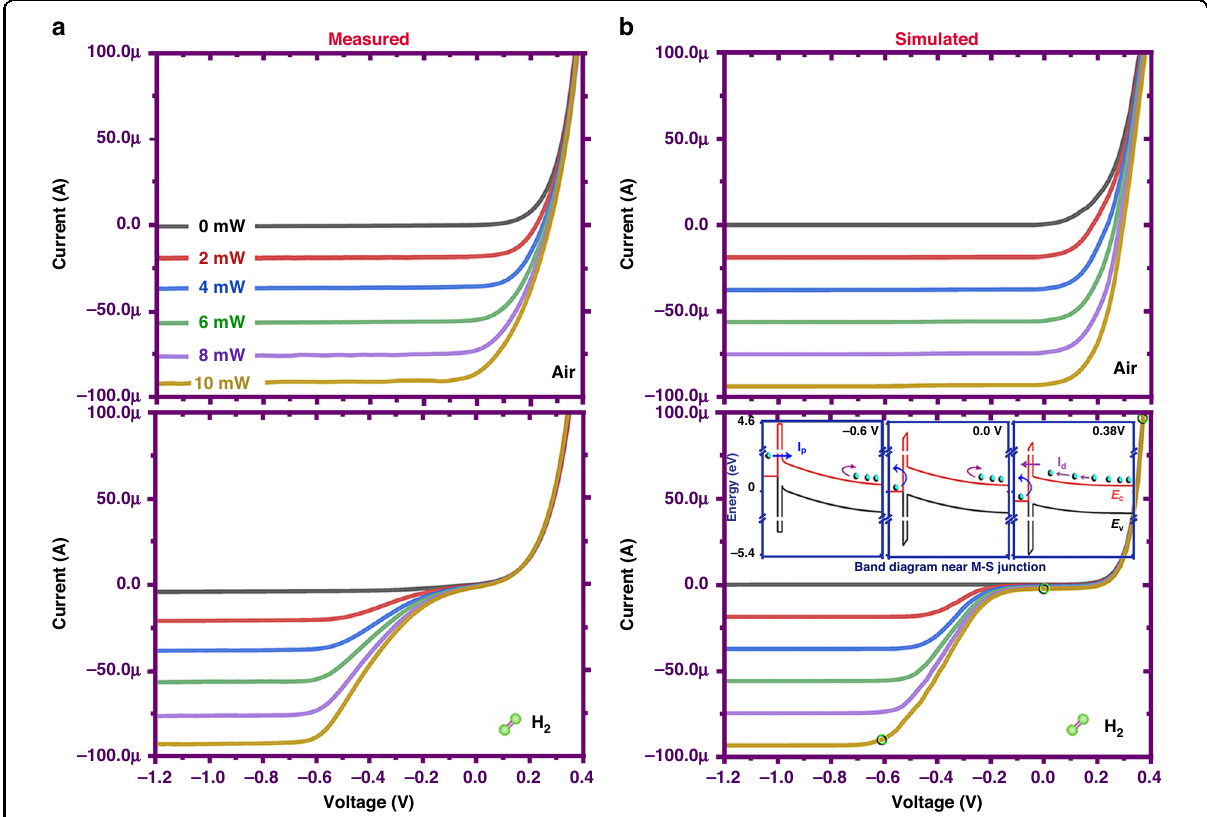
Fig. 4 Quantitative description of the hydrogen-induced S-kink effect using quantum tunneling model. a Measured and b Simulated light I – V curves of the MIS junction operating in the inert air and hydrogen-containing mixture gas (3% H 2 in air) with different illumination laser powers. The calculated energy band diagrams at three typical voltage biasing states are also present in the plot for the purpose of clarifying charge transfer mechanism for hydrogen-mediated junction response to external electrical